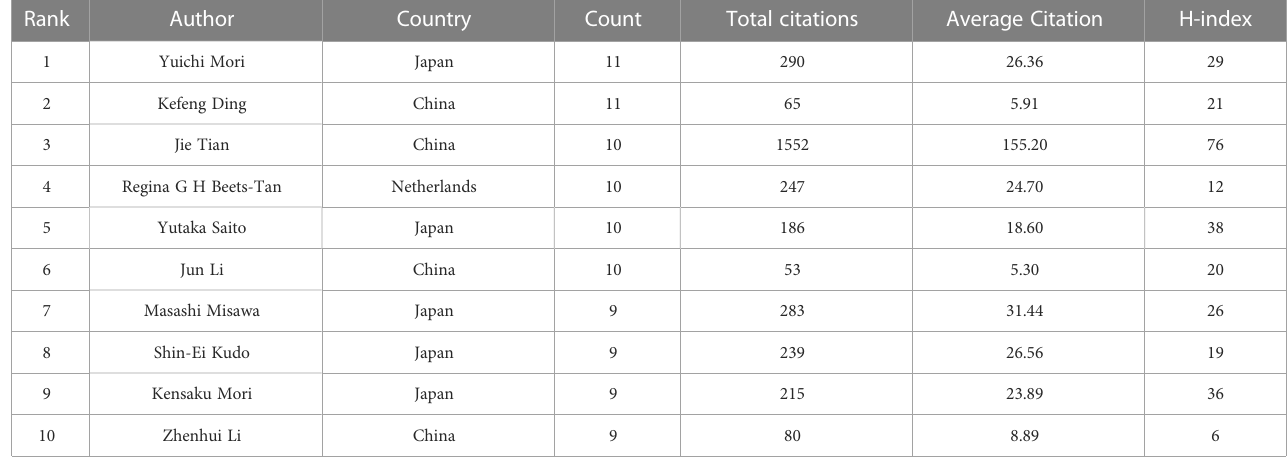
TABLE 2 Top 10 authors by publications.